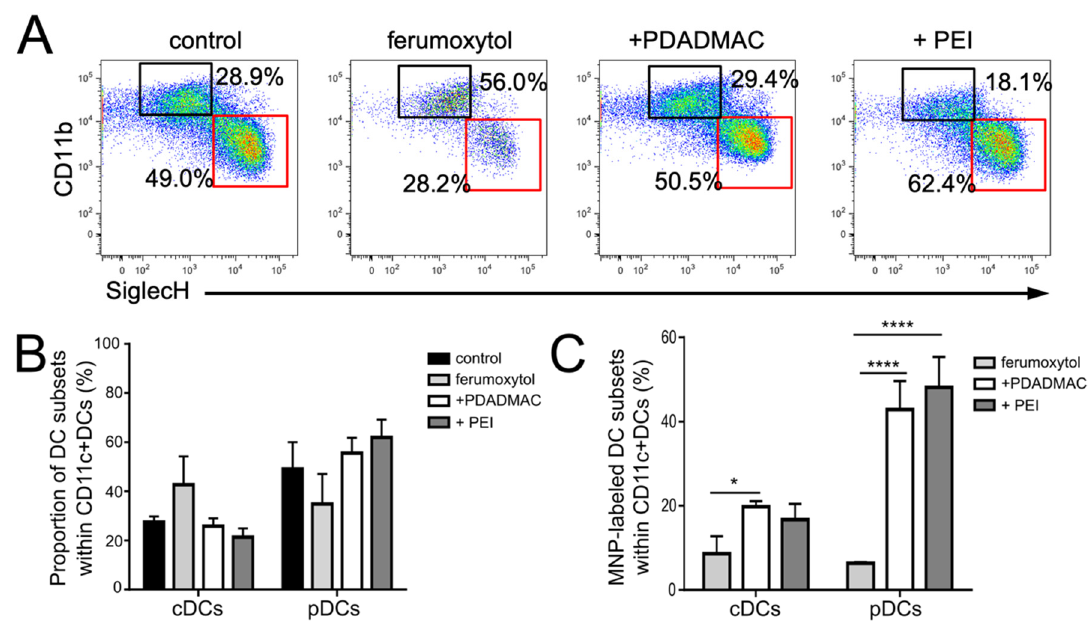
Figure 4. Uptake of uncoated and PE-coated ferumoxytol particles into steady-state DCs. FL-DCs after uptake of respective MNPs and magnetic separation of MNP-loaded cells were analyzed by flow cytometry. Unlabeled cells were used as control. ( A ) CD11c+ cells were gated for CD11b and SiglecH, as in Figure 2B, to specify cDC (black boxes) and pDC (red boxes) subsets. Representative dot plots from 3 independent experiments are shown. ( B ) Proportion of DC subsets within MNP-labeled FL-DCs compared to unlabeled control FL-DCs. ( C ) Percentage of MNP-labeled DC subsets within all FL-DCs. Data in ( B , C ) are mean values ± SEM ( n = 3; * p < 0.05, **** p < 0.0001).